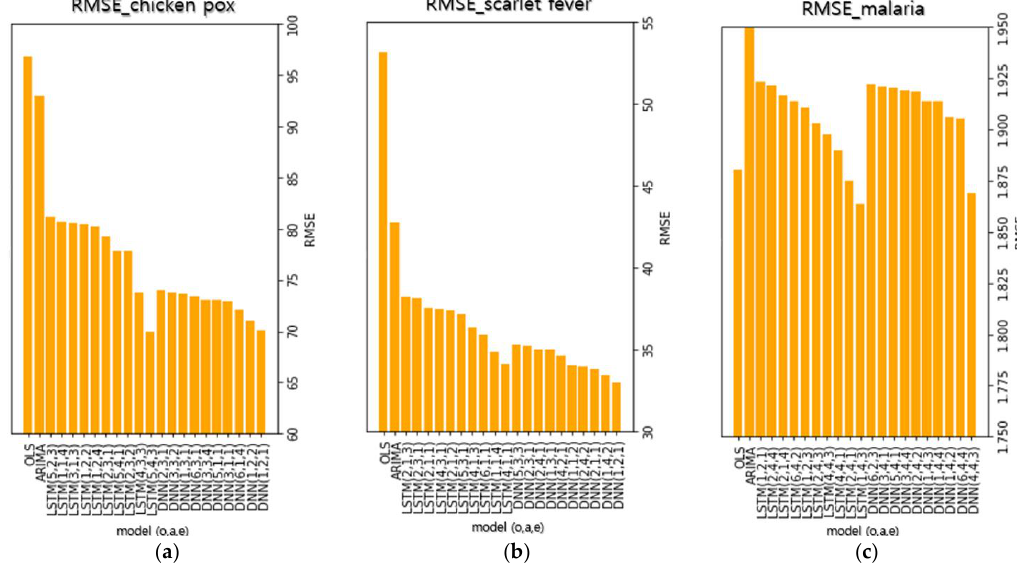
Figure 6. Ten models with the lowest RMSEs for each infectious disease. The numbers in parentheses indicate each model’s optimizer, activation, and number of epochs, respectively. (optimizer) 1: Adadelta, 2: Adagrad, 3: Adam, 4: Adamax, 5: Nadam, 6: RMSProp, and 7: SGD, (activation function) top-10 deep learning models and traditional analysis models with the lowest RMSEs in chickenpox, ( b ) The top-10 deep learning models and traditional analysis models with the lowest RMSEs in scarlet fever, ( c ) The top-10 deep learning models and traditional analysis models with the lowest RMSEs in malaria.